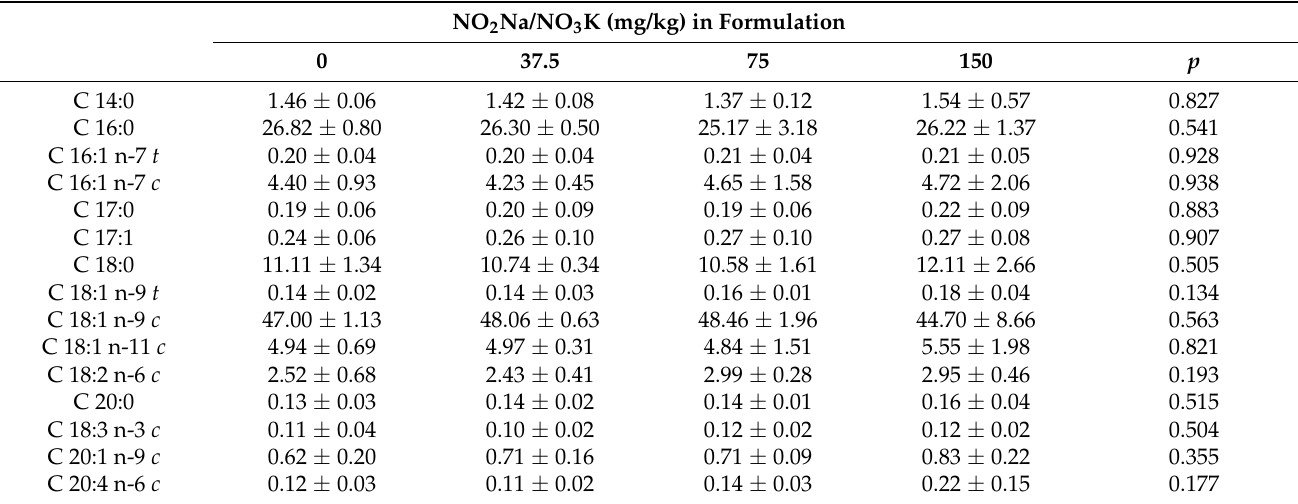
Table 2. Fatty acid composition (g/100 g total FAMEs) of dry-cured loins used in the in vitro digestion.